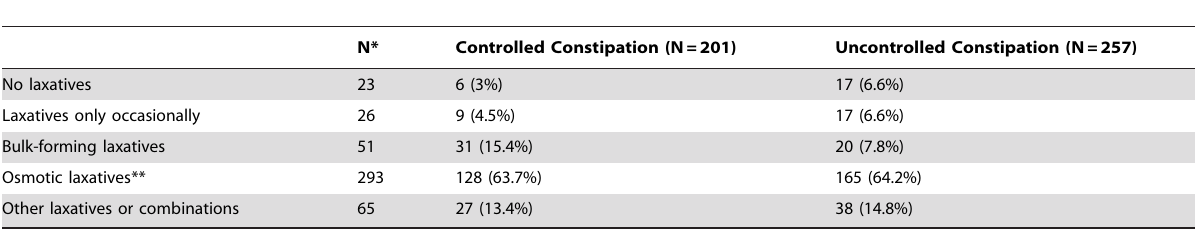
Table 2. Association between the laxative treatment used and the constipation control